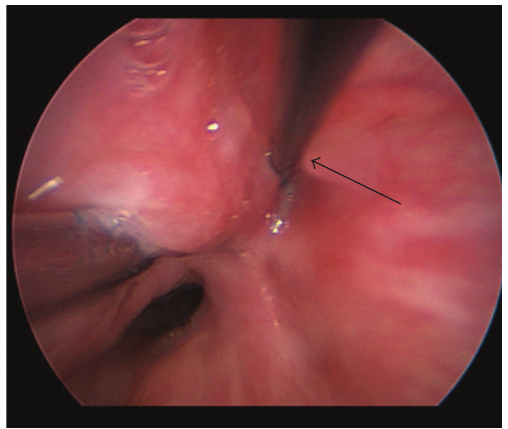
Figure 5: Ablated fistulous tract after cauterization with 40% TCA.